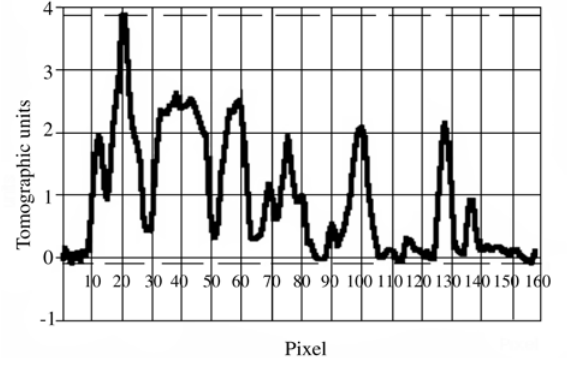
Figure 11. Selected transept of the 90 ppi ceramic sample’s CT